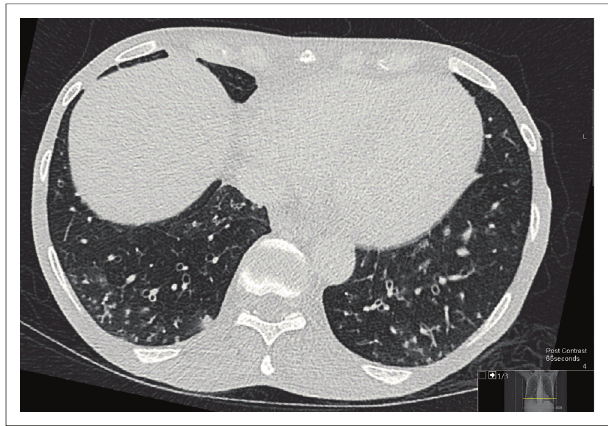
FIGURE 2: Axial computerised tomography of the chest demonstrating tree in bud appearances within the lung.